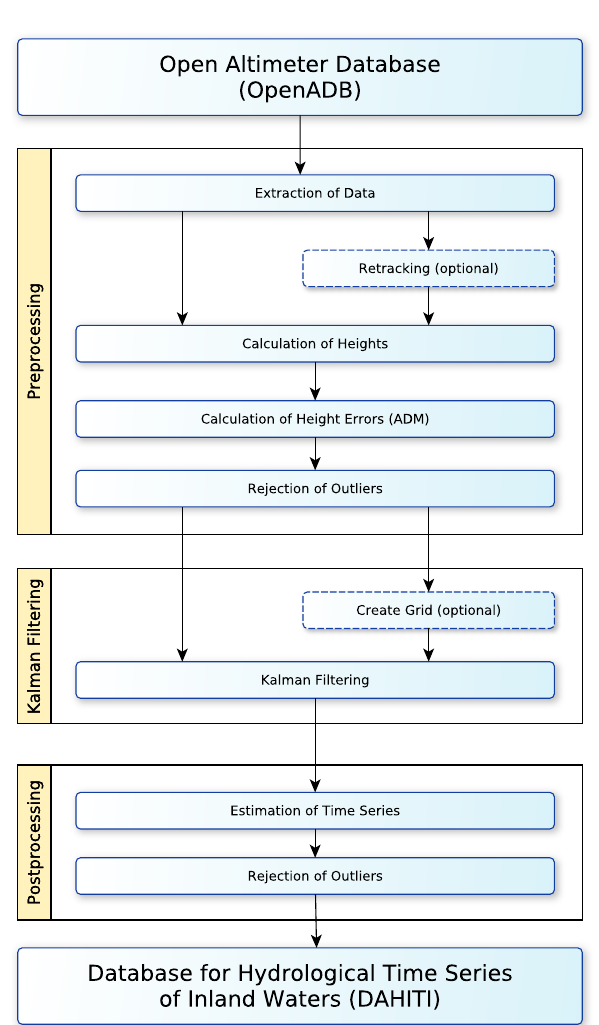
Figure 1. Processing strategy for the computation of water level time series for inland waters in DAHITI in three main steps: pre- processing, Kalman filtering, and